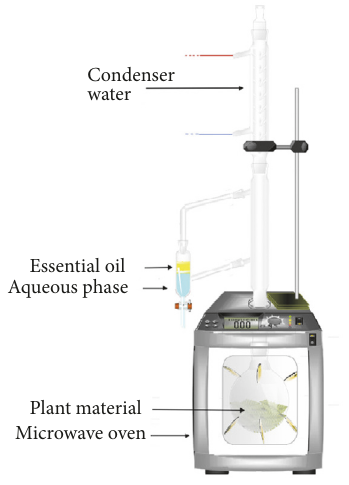
Figure 1: Schematic representation of the